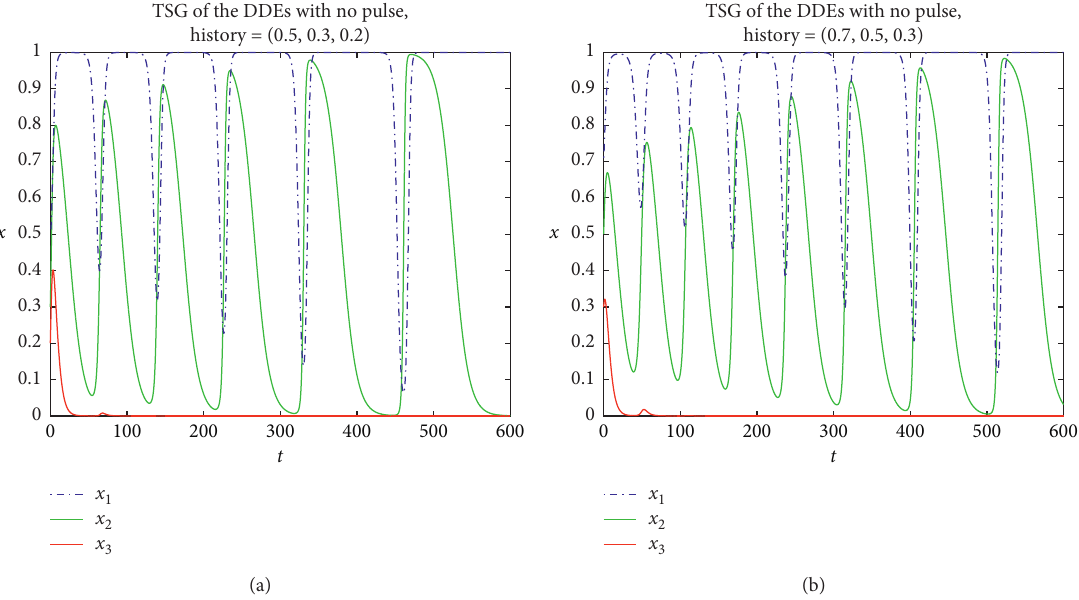
Figure 2: TSGs when the DIDEs (2) have delays but no pulse. Lags � ( 3 , 5 , 7 ) /30. (a) ( x , x ,x )| � P ( 0 . 7 , 0 . 5 , 0 . 3 ) ( x t � 0 1 2 3 1